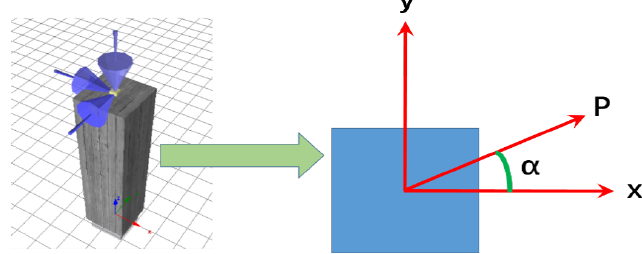
Figure 14. Lateral bi-directional loading for RRC columns.